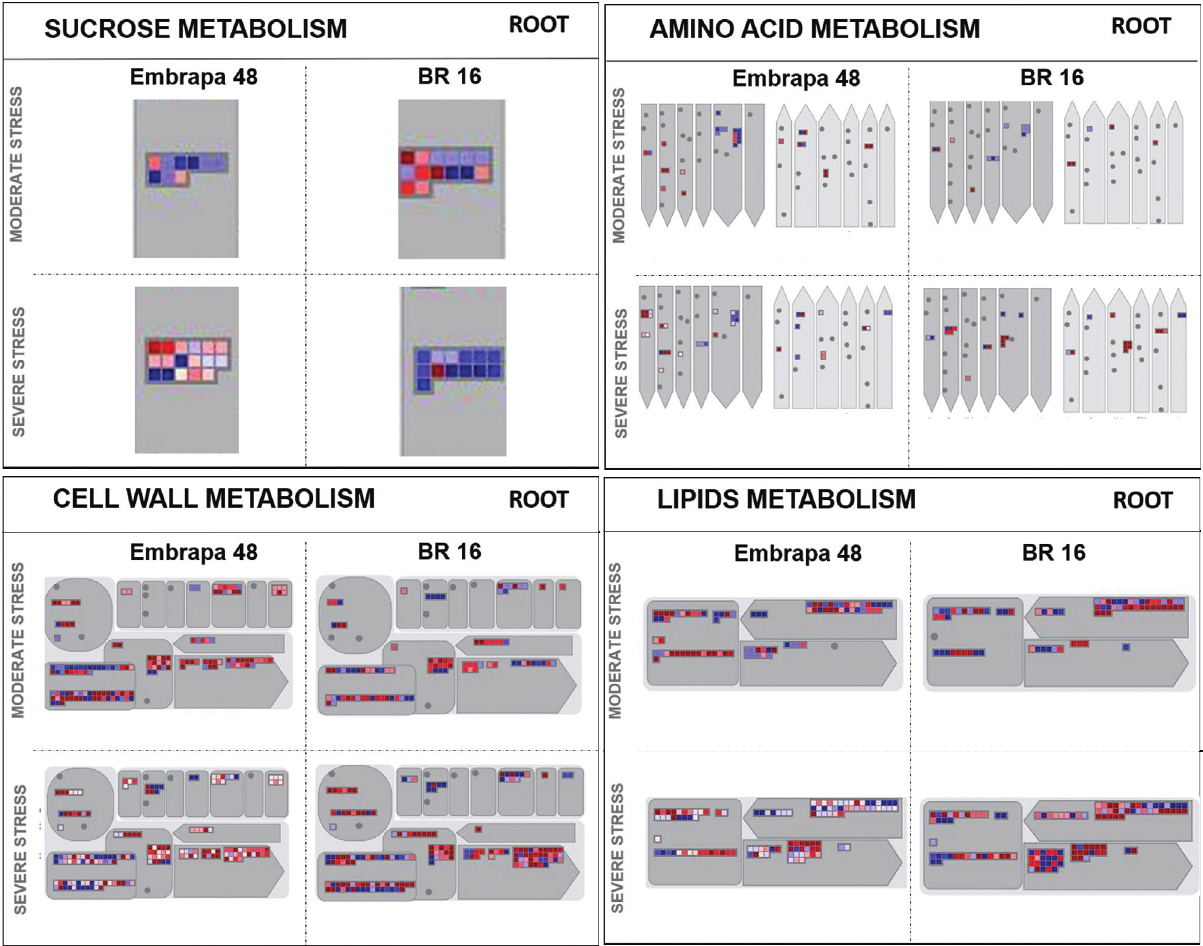
Figure 8 - Metabolism overview mapping (MapMan 3.6 ORC). Genes that were differentially expressed in response to water deficit were mapped to spe- cific stress-related gene groups (sucrose, amino acid, cell wall and lipid metabolism) for root from Embrapa 48 and BR 16 under moderate and severe stress. The color scale shows the log2 fold-change: red = down-regulated and blue =